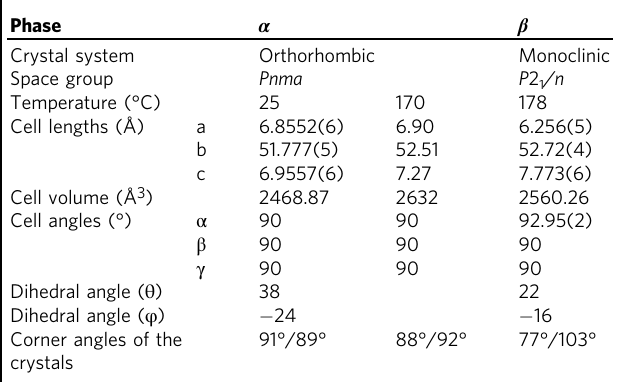
Table 1 Cell parameters of the 4-DBpFO crystal at different temperatures Phase β Crystal system